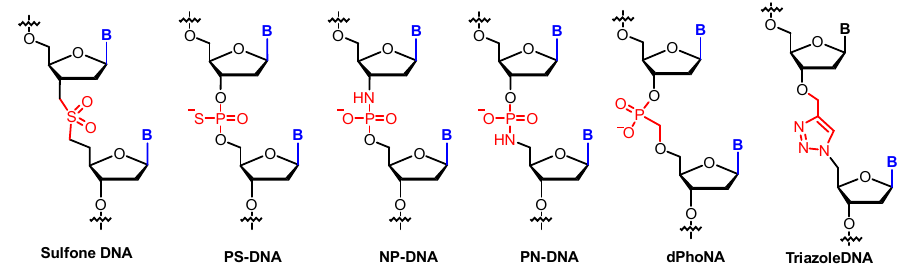
Figure 5. Examples of phosphate linkage-modified XNAs.